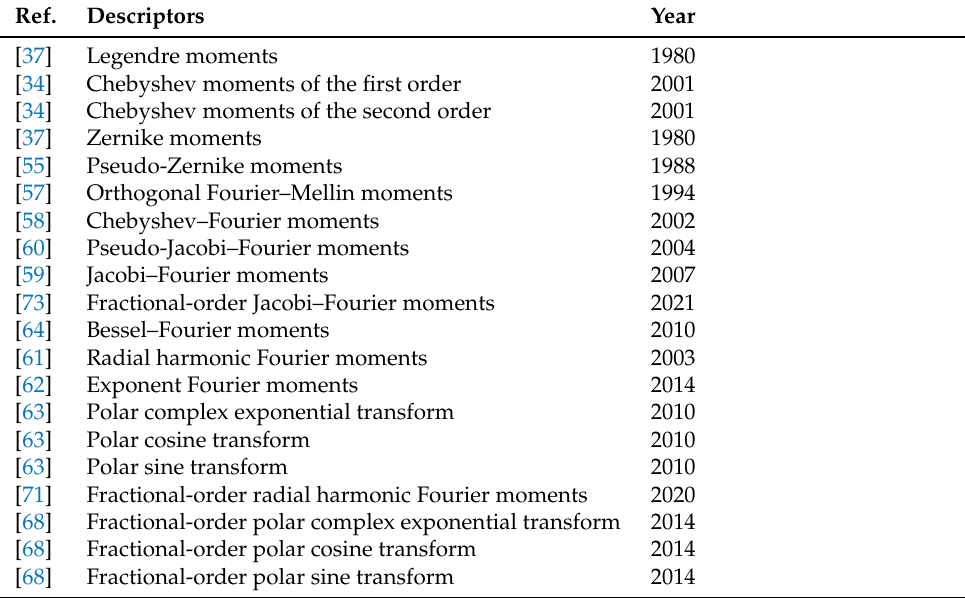
Table 1. The year when the moments were first proposed.